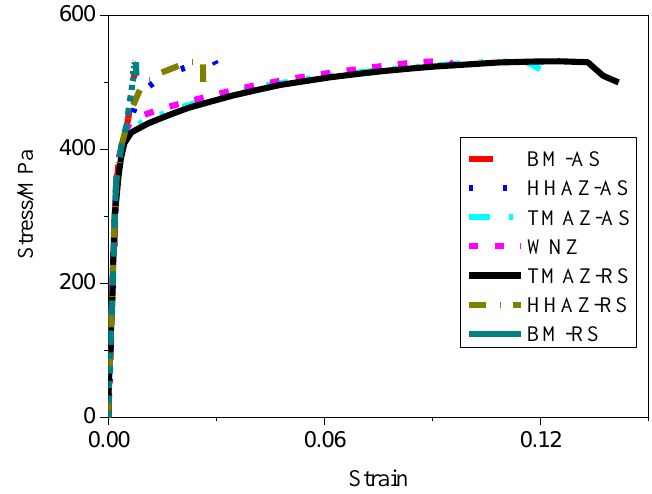
Figure 8. Stress – strain curves of the FSW joint.